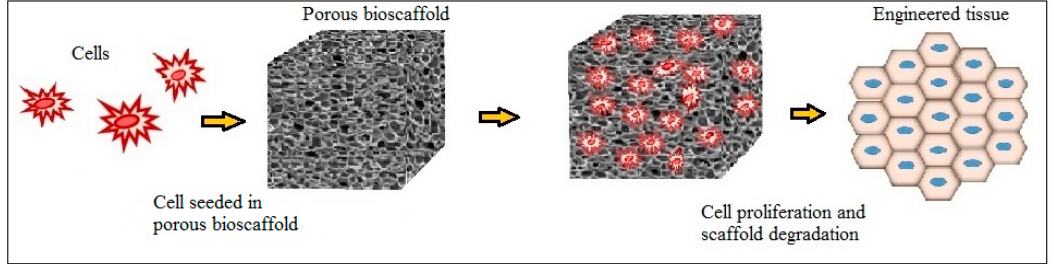
Figure 1. Schematic representation of tissue regeneration using porous bioscaffold.